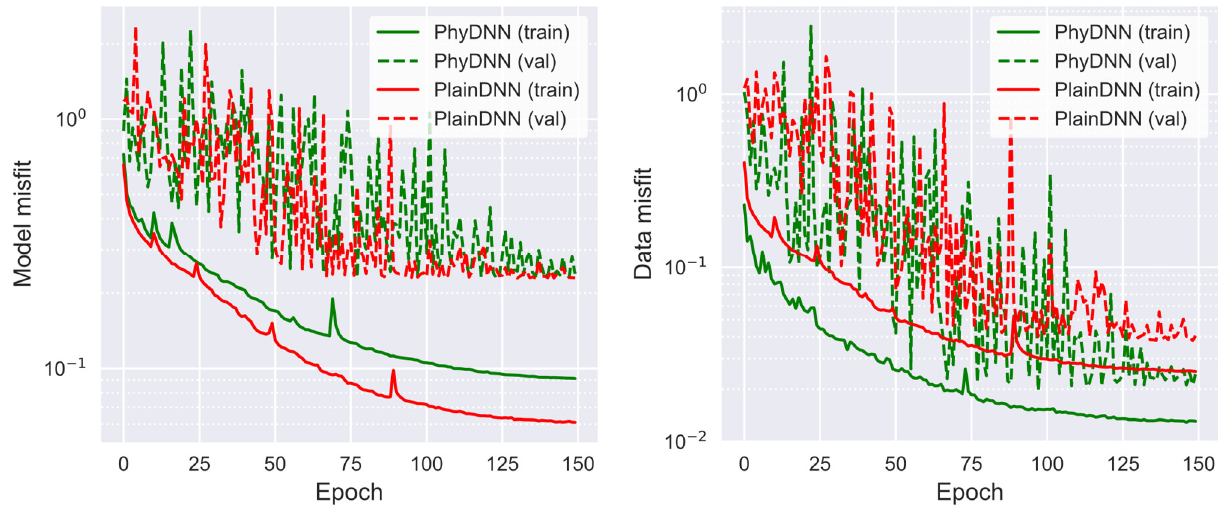
Figure 5. The model and data misfit convergence curves of the training and validation sets in the training process from the PlainDNN and PhyDNN.